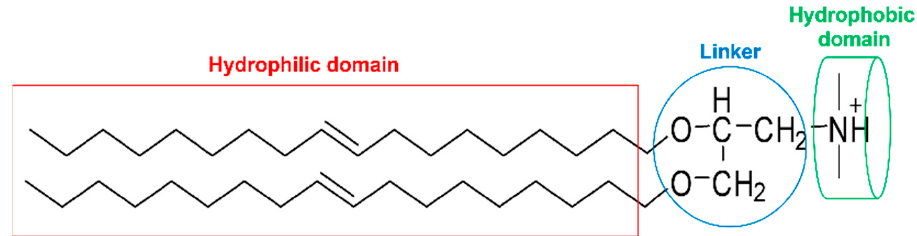
Figure 1. The general chemical structure of lipid.